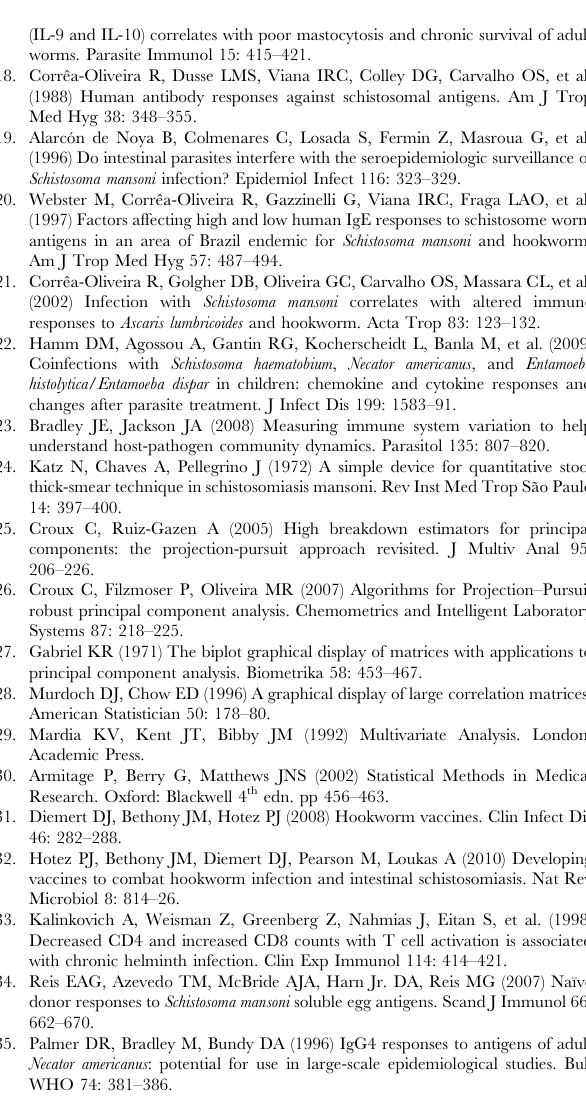
Figure S3 Robust principal component analysis (PCA) of log-transformed cytokine and chemokine secretion in N PBMCs stimulated with ES antigen. Footnotes: The principal component scores for individuals mono- ( ) and co-infected ( m ) with hookworm are shown. The respective mean values are shown as open symbols, with 95% confidence ellipses ( p value for bivariate T 2 test is 0.08). The arrows show the strongest loadings, i.e. contributions of the original variables to the principal components. Table S1 Correlations between hookworm-specific an- tibody responses and hookworm egg counts in